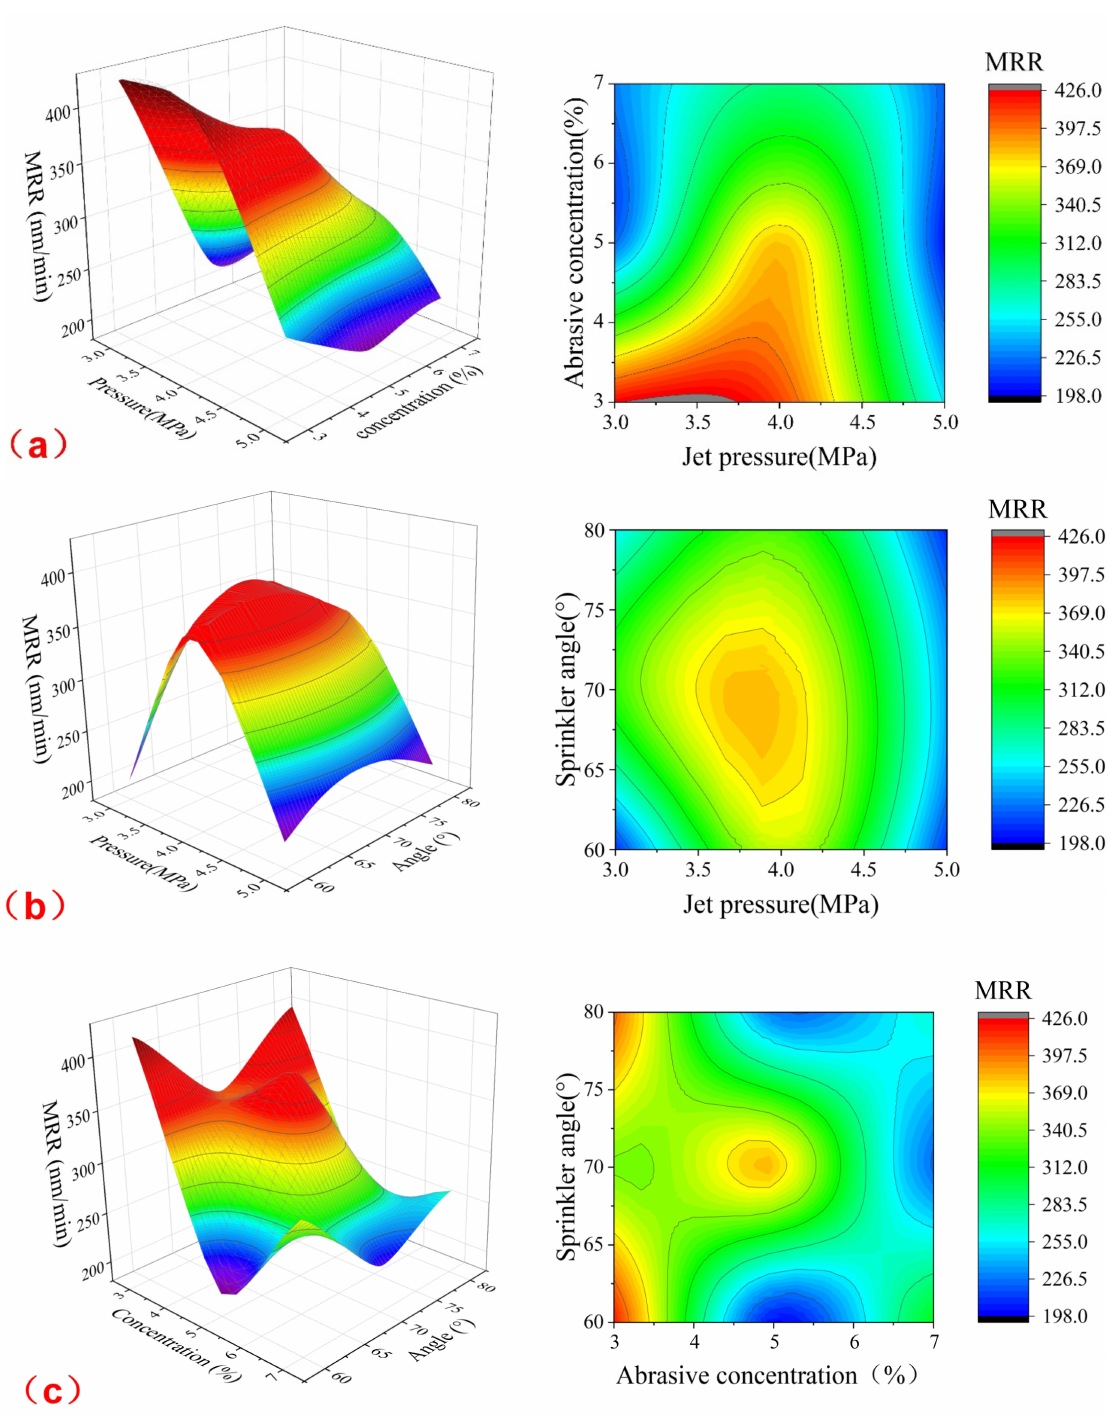
Figure 3. Response surface and contour plot of material removal rate and various factors: ( a ) Re- sponse surface and contour plot of material removal rate and jet pressure and abrasive concentration; ( b ) response surface and contour plot of material removal rate to jet pressure and nozzle angle; ( c ) re- sponse surface and contour plot of material removal rate to nozzle angle and abrasive